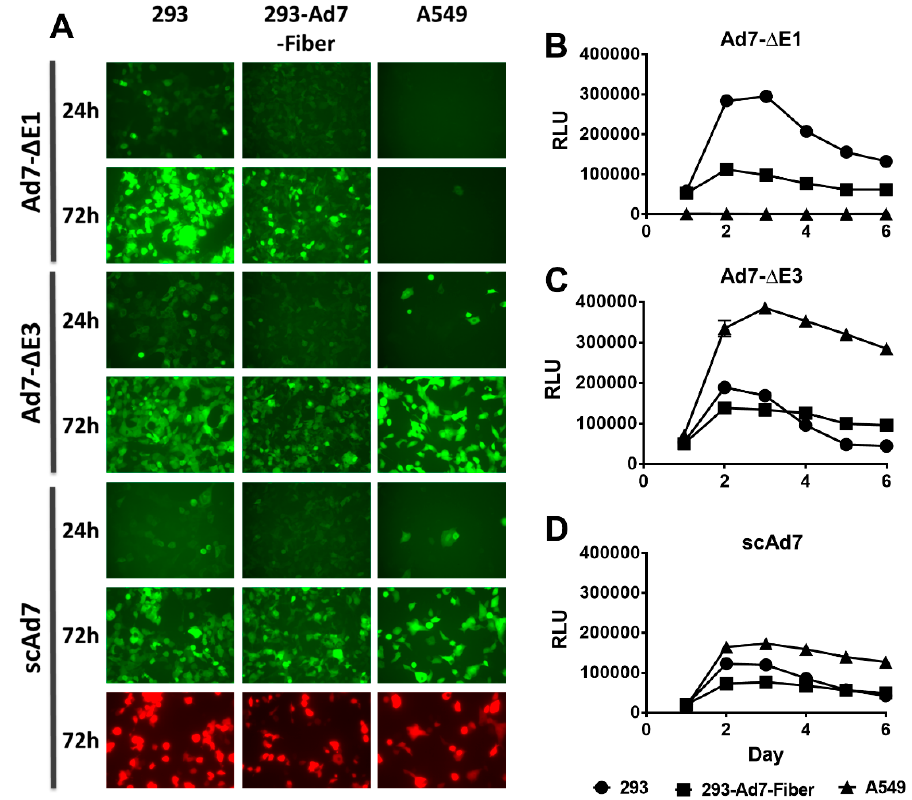
Figure 2. In vitro reporter gene expression of the Ad7 viruses in three cell lines 293, 293-Ad7-Fiber, and A549 cells, grown in 6-well tissue culture plates and infected with the indicated viruses at 50 vp / cell ( A ). Fluorescent images of GFP expression were taken at 24 and 72 h post-infection at 10 × magnification. All pictures were imaged at the same light intensity for comparison of reporter gene expression. The luciferase kinetics of each virus was also examined by infecting 293, 293-Ad7-Fiber, and A549 cells with the indicated viruses at 50 vp / cell. Luciferase expression was determined at 24 h intervals for six days. The luciferase expression kinetics of the Ad7- ∆ E1, Ad7- ∆ E3, and scAd7 are shown in panels B, C, and D, respectively. Data are expressed as relative luminescence units (RLU) and error bars indicate standard error for 4 plates replicates.